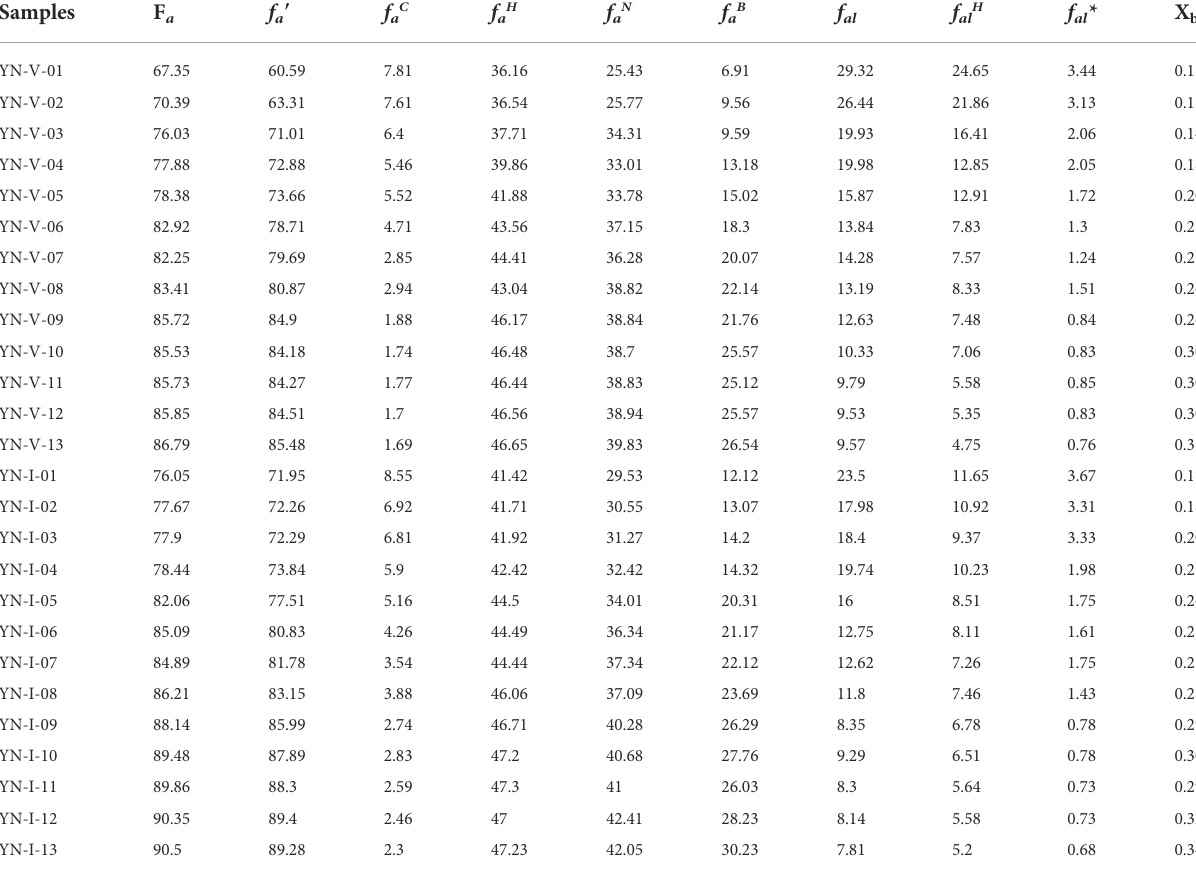
TABLE 7 13 C NMR parameters of thermally simulated vitrinite and inertinite samples.